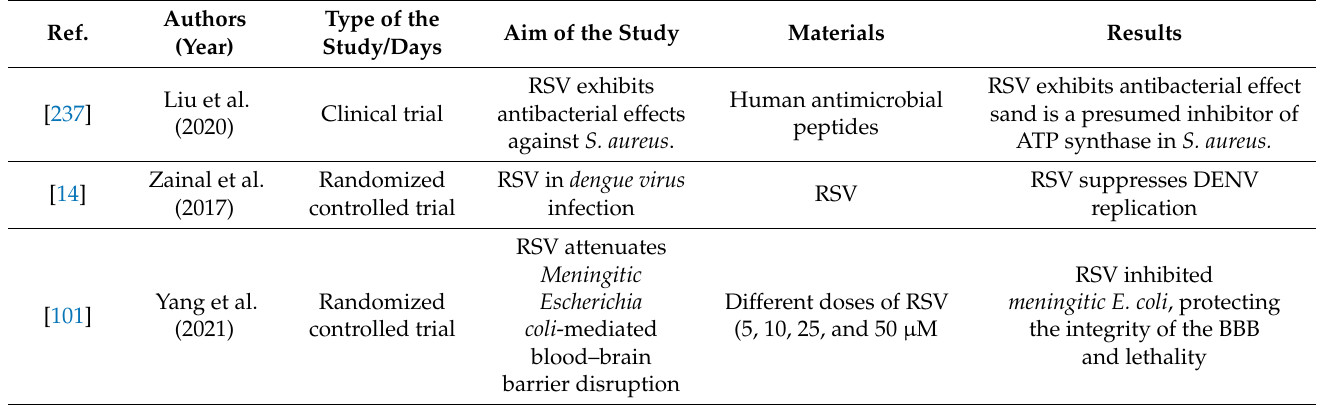
Table 5. Included studies that focus on the immune-system–microbiota–resveratrol axis.